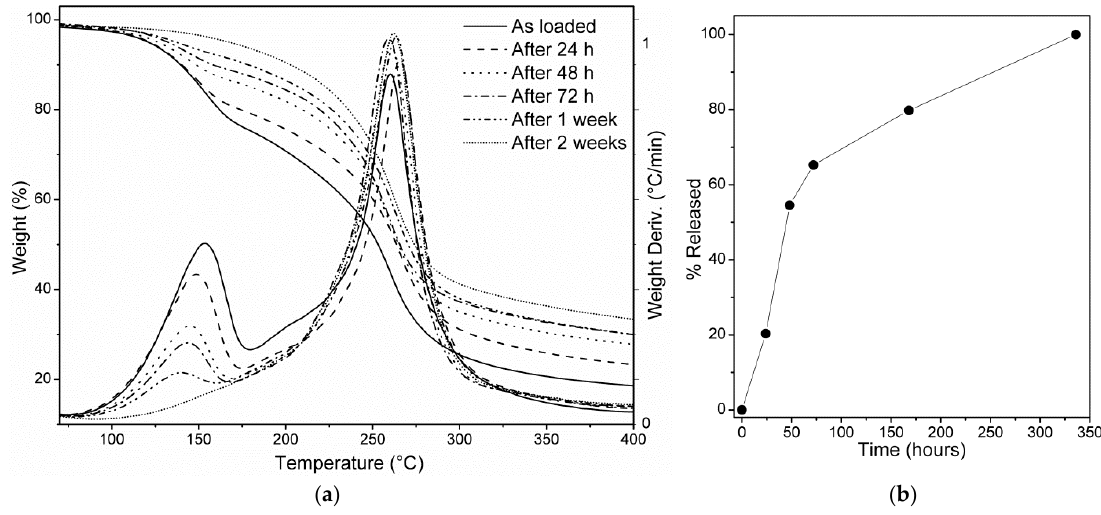
Figure 2. ( a ) Thermogravimetric analysis (TGA) of the as-loaded polymer 24 h, 48 h, 72 h, 1 week, and 2 weeks after the loading step, respectively. ( b ) DEET releasing